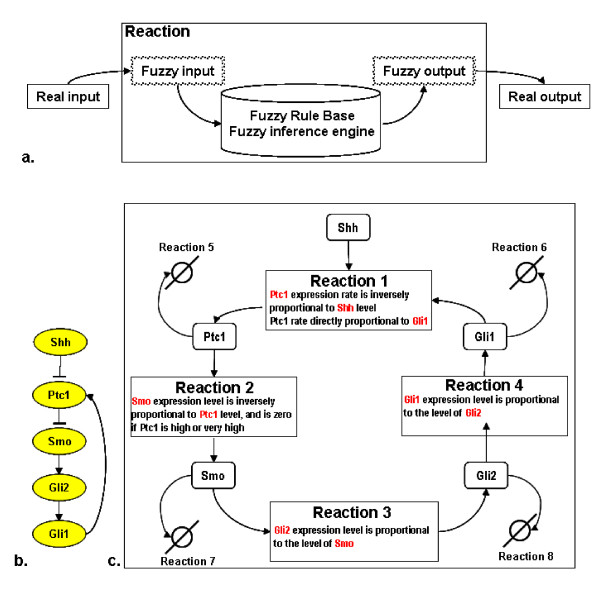
a. Each reaction or process is a fuzzy inference system, with real inputs and real outputs. b. A subset of the hedgehog pathway is represented here. c. The pathway in b. is now represented as a network of fuzzy inference systems. Reactions are linked together by variables that may participate in more than one reaction. At every time step, all reactions are executed and variables are updated.